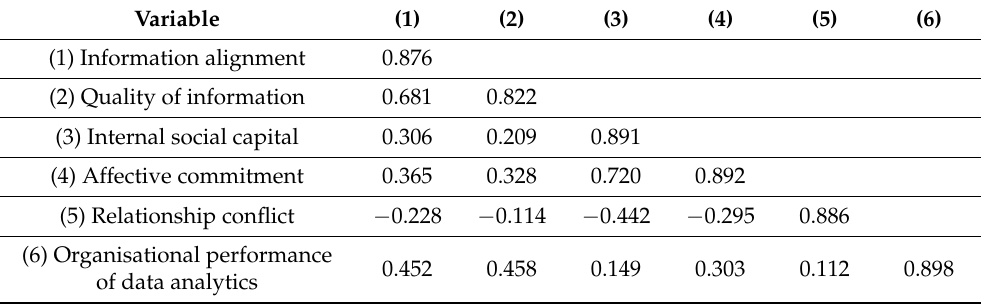
Table 5. Discriminant validity.